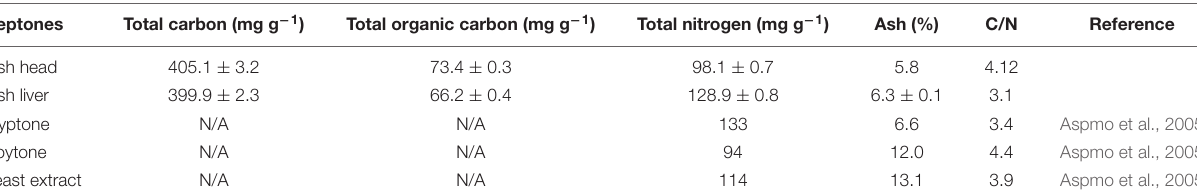
TABLE 3 | Characterization of fish waste generated peptones.